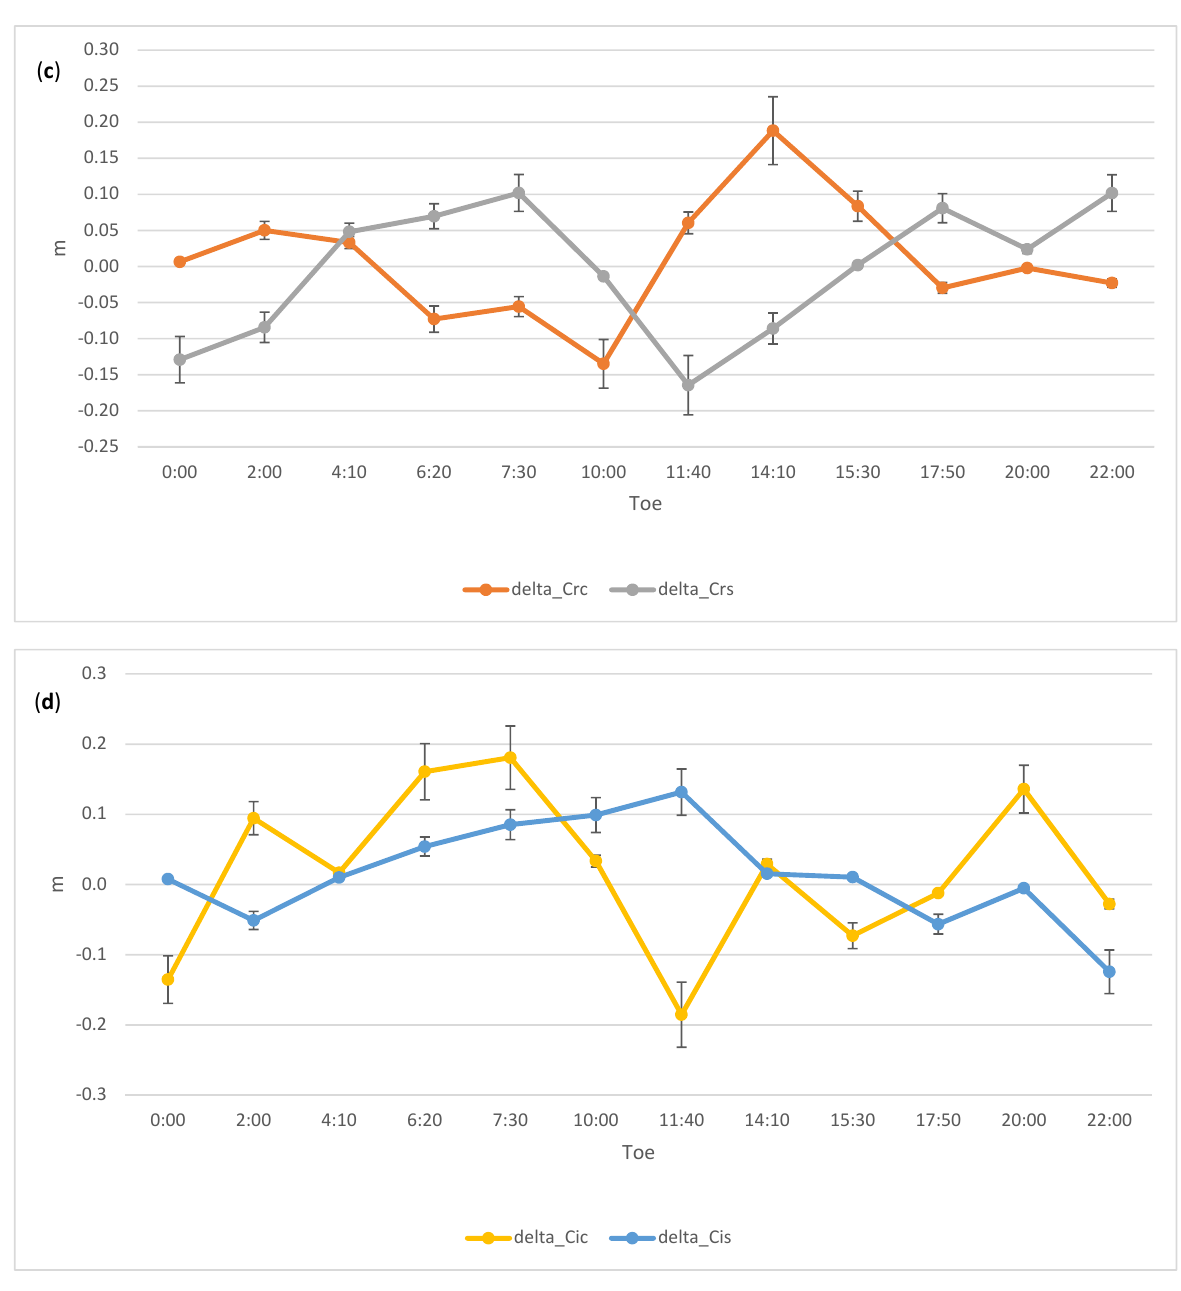
Figure 5 . Best fitting corrections to ( a )the clock polynomial parameters, ( b ) Mean anomaly at Toe and amplitude of the cosine and sine perturbations along track due to the second zonal harmonic (Cuc, Cus), and amplitude of the cosine and sine perturbations in the ( c ) radial (Crc, Crs) and ( d ) cross track (Cic, Cis) directions. To convert to radians the scale factor 26 × 10 6 m should be used. Error bars are 1 sigma formal uncertainties. Satellite E01 for day 2 January 2020. Table 3. Helmert parameters relating the origin, orientation and scale of the Broadcast reference frame of C07 relative to the IGS14 frame of the SP3 precise ephemeris for SV C07, 2 January 2020. The scale factor accounts for the Center of Mass–Antenna Phase Center correction in the radial direction. The translational parameters were constrained to zero due to lack of geometry in a IGSO